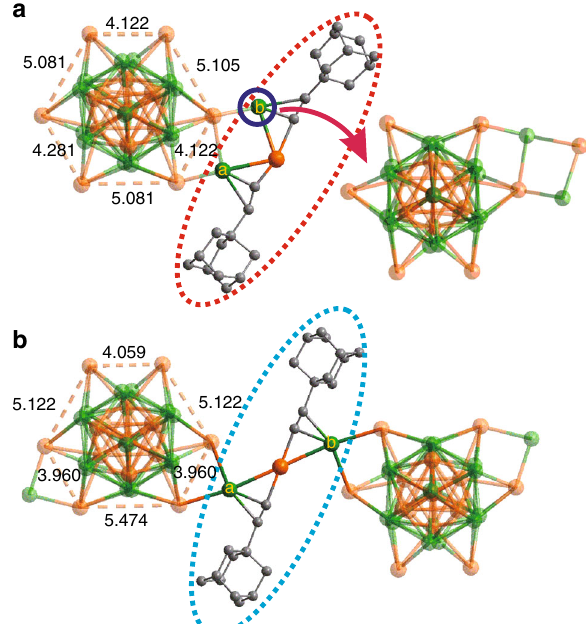
Fig. 3 Different “ Ag – L – Au – L – Ag ” units of (AuAg) 34 and (AuAg) 34n . The Au – Au distances in the distorted Au 6 hexagon and Ag – Ag distance in the “ Ag – Au – Ag ” unit of a (AuAg) 34 and b (AuAg) 34n . Colors: golden and green, Au/Ag; gray, C. All hydrogen atoms are omitted for clarity.